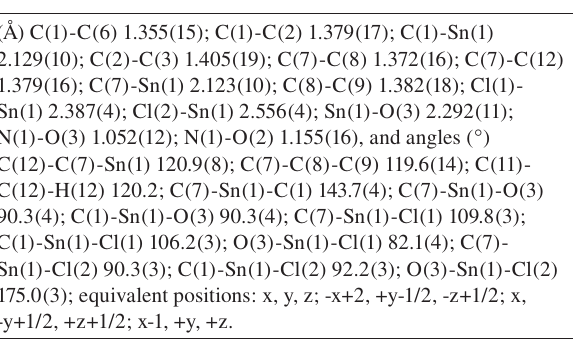
Table 2 Selected bond